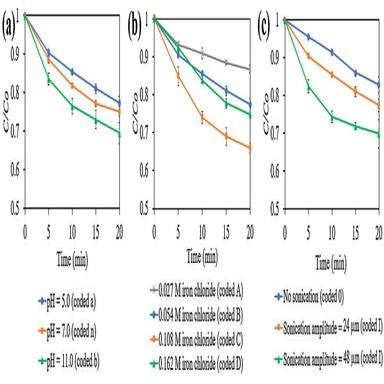
Effects of BC/nZVI synthesis factors on its pNDA bleaching efficiency. The effects of (a) pH of the BC and iron chloride mixture (sonication amplitude = 24mm, iron chloride concentration = 0.054 M), (b) iron chloride concentration (sonication amplitude = 24mm, pH = 5.0), and (c) sonication amplitude (iron chloride concentration = 0.054 M, pH = 5.0). Initial pNDA concentration = 10mM, adsorbent dose = 250 mg L1 . Error bars represent standard deviation of triplicate experiments.